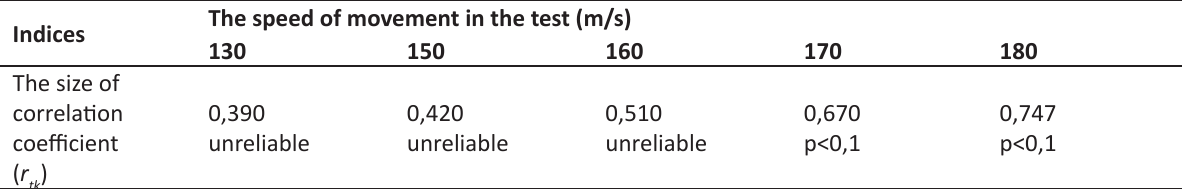
Table 5. Correlation of the speed of movement of cyclists in the tests and results in the individual pursuit race at 4 km